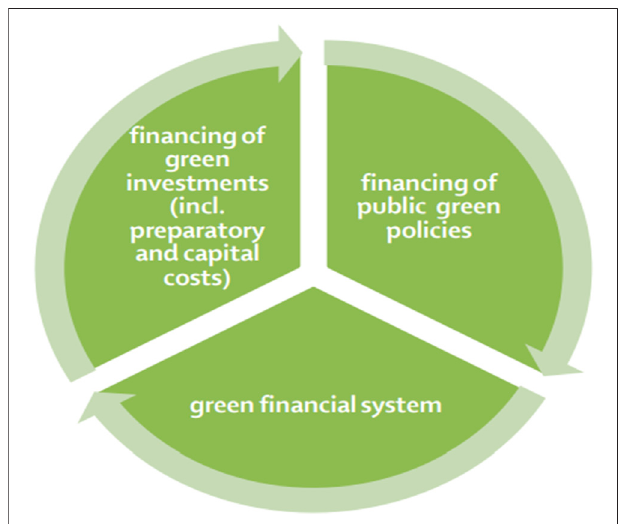
FIGURE 1 | Composition of green fi nance. Source: Lindenberg